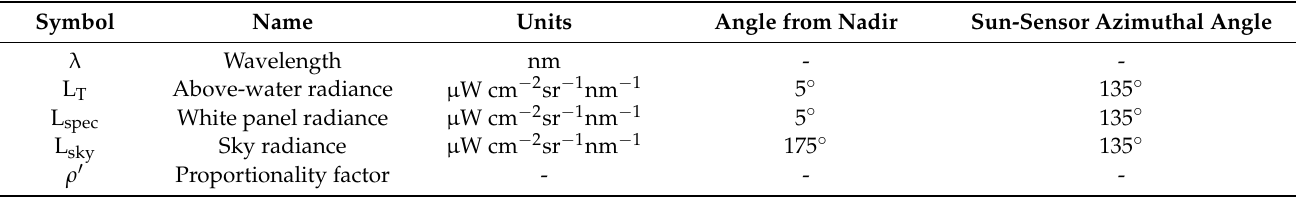
Table 1. Spectral parameters used to calculate above-water reflectance, as per Equation (1). All spectral measurements were collected using a calibrated ASD Fieldspec Handheld2 spectroradiometer with a one-degree fore optic (full viewing-angle), which detects a wavelength range from 325–1075 nm at 1 nm